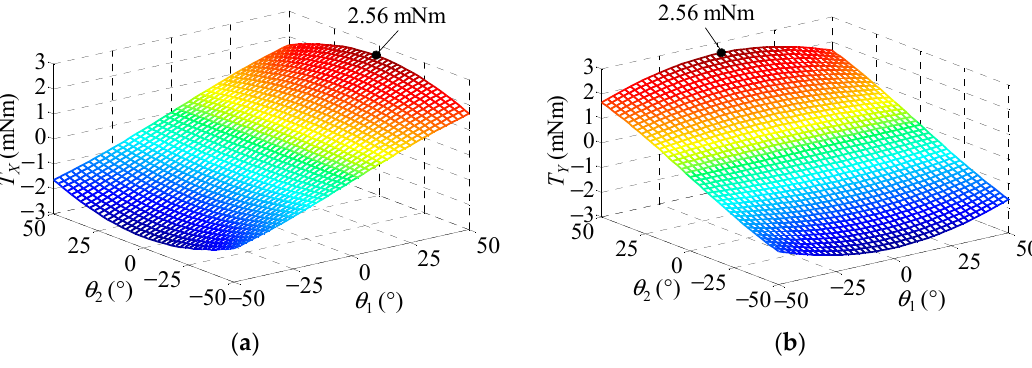
Figure 24. Calculation results of unbalanced torque produced by gravity effect. ( a ) T X ; ( b ) T Y .